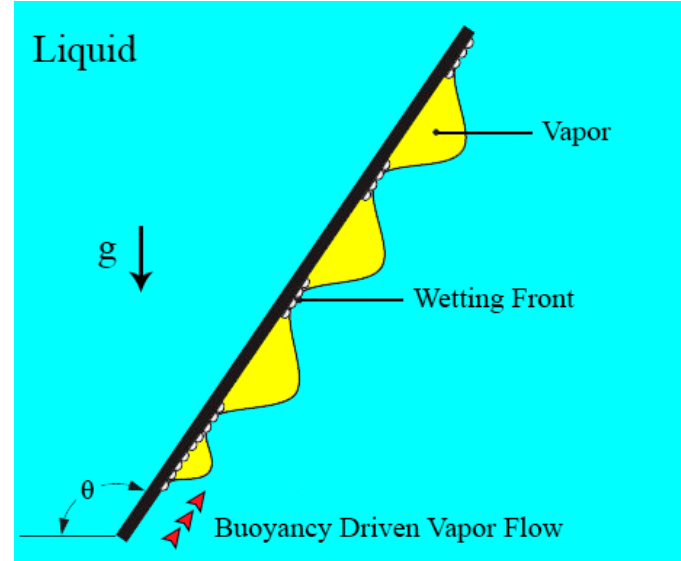
Figure 18. Illustration of interfacial lift-off CHF model on a near perpendicular surface in pool boiling. Adapted from Howard and Mudawar. Reproduced from [265], Elsevier: 1999.